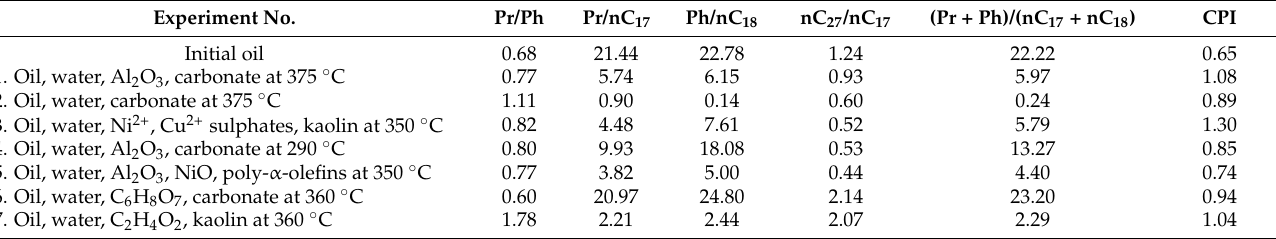
Table 3. Geochemical coefficients of the original and converted